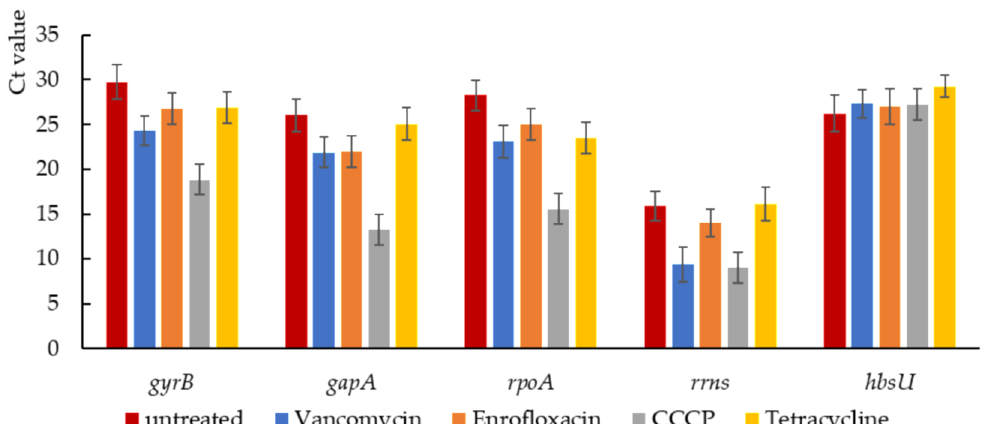
Figure 5. Ct value of five reference gene candidates. In order to choose a relatively stable reference gene for qPCR, expression of five commonly used reference gene candidates were analyzed. In five samples including untreated cells as control and four persister samples isolated from different treatments, the expression of gyrB , rrns , gapA , rpoA and hbsU were analyzed by qPCR. Result showed that hbsU was relatively stable compared to other reference gene candidates.